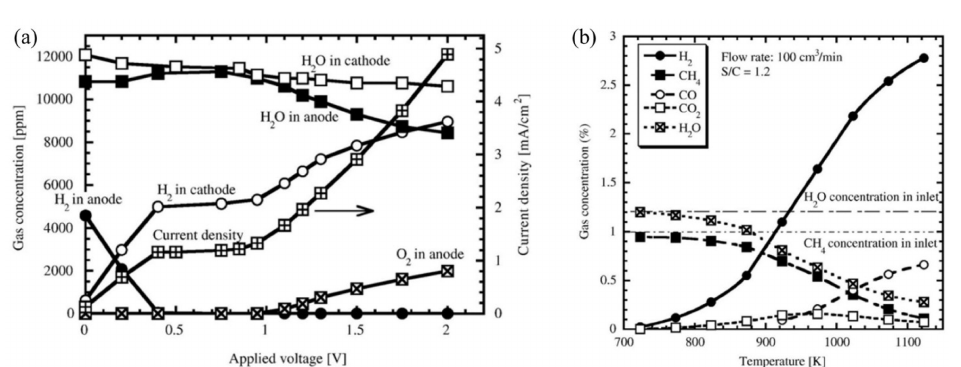
Figure 12. ( a ) Variation of current density and gas concentrations at the outlet of the anode and cathode as a function of applied voltage, ( b ) gas concentration change at the outlet as a function of temperature; here hydrogen, methane, carbon monoxide, carbon-di oxide, and water vapor are shown. Reprinted with permission from Ref. [97]. Copyright 2010